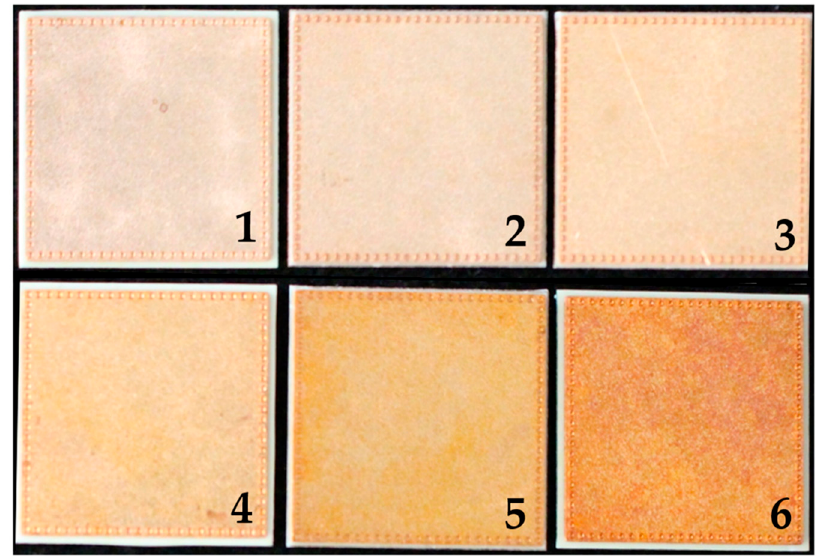
Figure 1. Direct bonded copper Curamik ® Power substrates. ( 1 ) is an example of sample type 1, ( 2 ) sample type 2, ( 3 ) sample type 3, ( 4 ) sample type 4, ( 5 ) sample type 5 and ( 6 ) sample type 6.